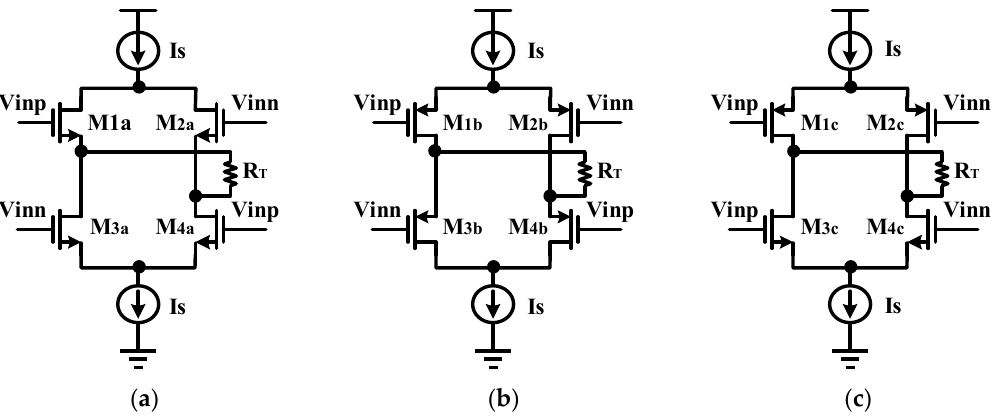
Figure 2. Simplistic circuit of LVDS output driver: ( a ) NMOS-only style; ( b ) PMOS-only style; ( c ) Complementary MOS style.